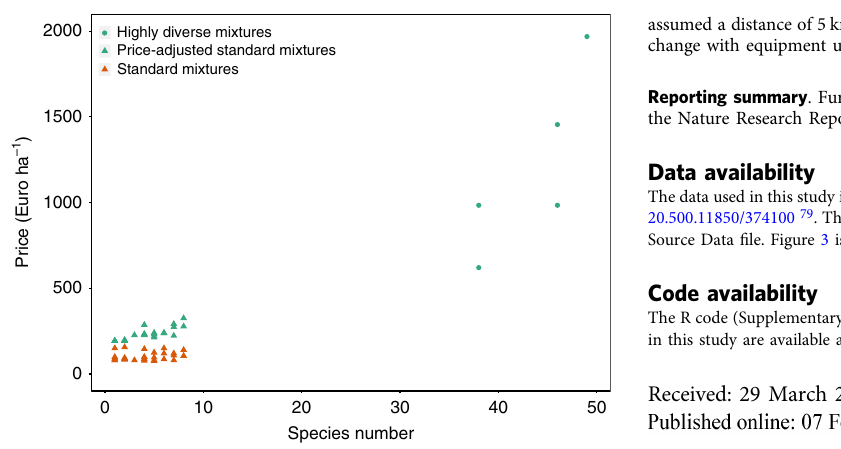
Fig. 7 Relationship of seed mixtures prices and number of species in the mixture. The green cycles are highly diverse mixture (38 – 49 species). Orange triangles are standard mixtures (1 – 8 species). Green triangles are price-adjusted standard mixtures, based on seed costs of the shop focusing on highly diverse regional mixtures. Source data are provided as a Source Data fi